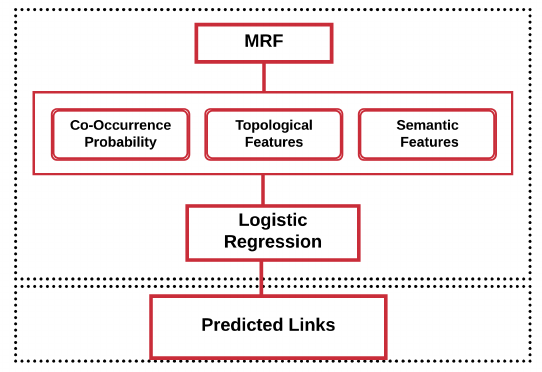
Figure 12. Local Co-Occurrence